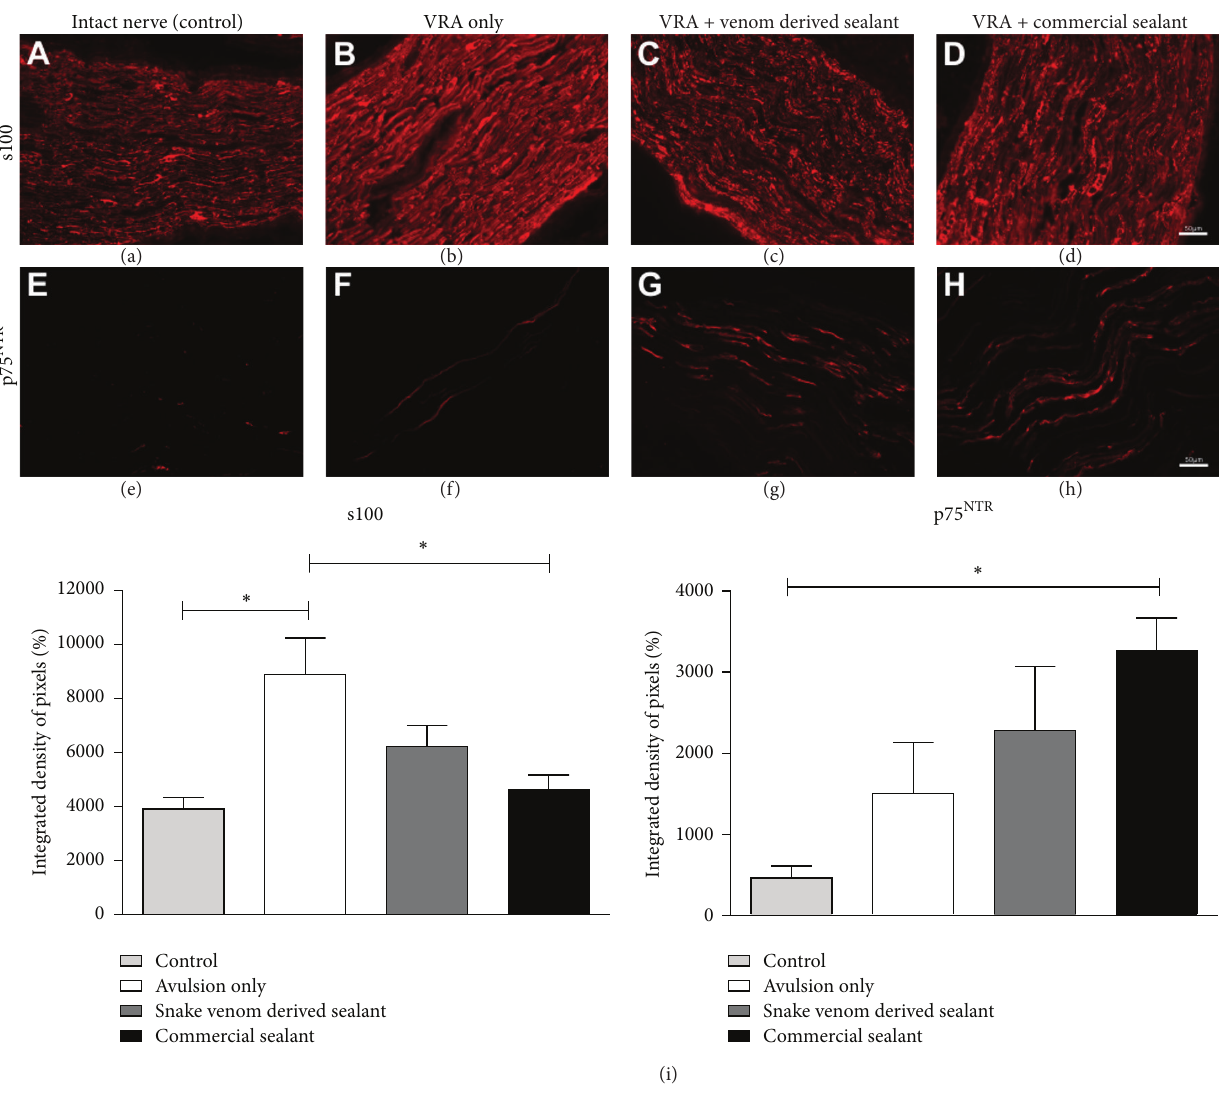
Figure 5: Immunolabeling anti-p 75 NTR and S100 in sciatic nerves, 4 weeks after ventral root avulsion and repair. Increased labeling is observed in all experimental groups as compared to control. S100: (a) intact nerve; (b, c, and d) ventral root avulsion (VRA); VRA followed by reimplantation with fibrin sealant derived from snake venom; ventral root avulsion followed by reimplantation with commercial fibrin sealant, respectively. p75: (e) intact nerve; (f, g, and h) ventral root avulsion (VRA); VRA followed by reimplantation with fibrin sealant derived from snake venom; ventral root avulsion followed by reimplantation with commercial fibrin sealant, respectively. (i) Quantification of S100 and p 75 NTR labeling by the integrated density of pixels. Scale bar = 50 𝜇 m. Mean ± SE. ∗ 𝑝 < 0.05